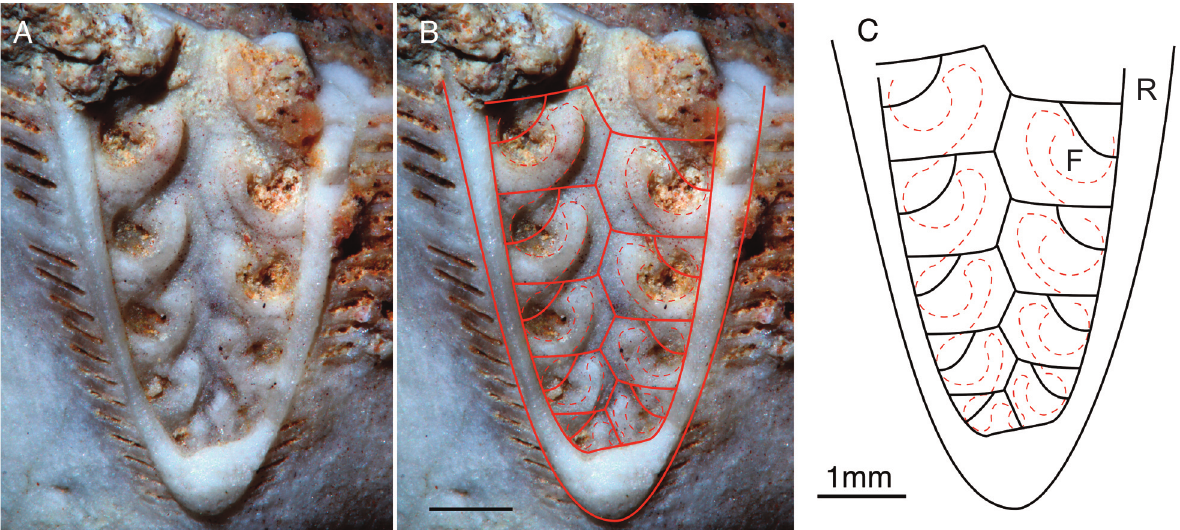
Fig. 4. Arrangement of floor plates in the ambulacra of Cystoblastus kokeni Jaekel, TUG 1727­548, Kukruse Regional Stage (Viivikonna Formation), Kohtla, Estonia. A , photograph of ambulacrum D to show plate sutures, main food groove, facets and slits for pectinirhombs. B , the same with outlines of plate sutures (solid) and ambulacral structures (dashed) superimposed. C , line drawing of plate sutures and ambulacral structures. F, ambulacral facet; R, rim of ambulacrum. Note that the radial plate, which surrounds the ambulacrum, does not continue beneath the ambulacral plates (top).